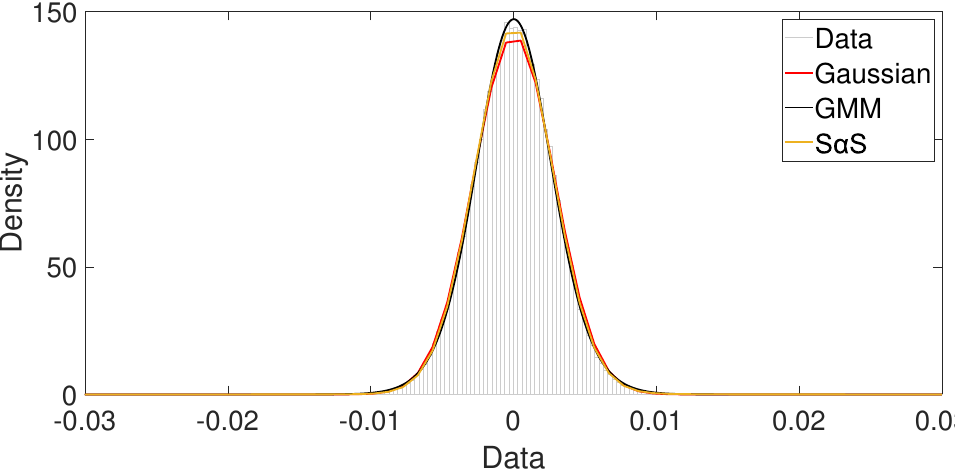
Figure 15. Hall scenario: Visual comparison among Gaussian, GMM and S α S PDF fitting.